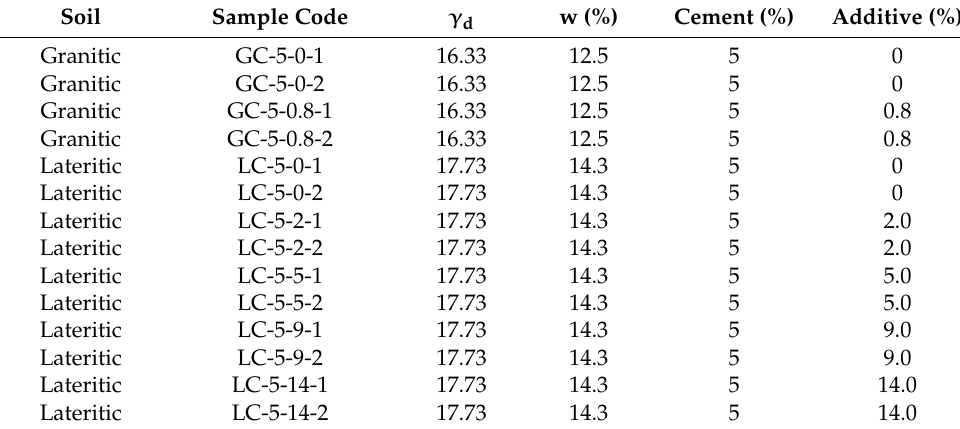
Table 6. Initial conditions of the wetting-drying